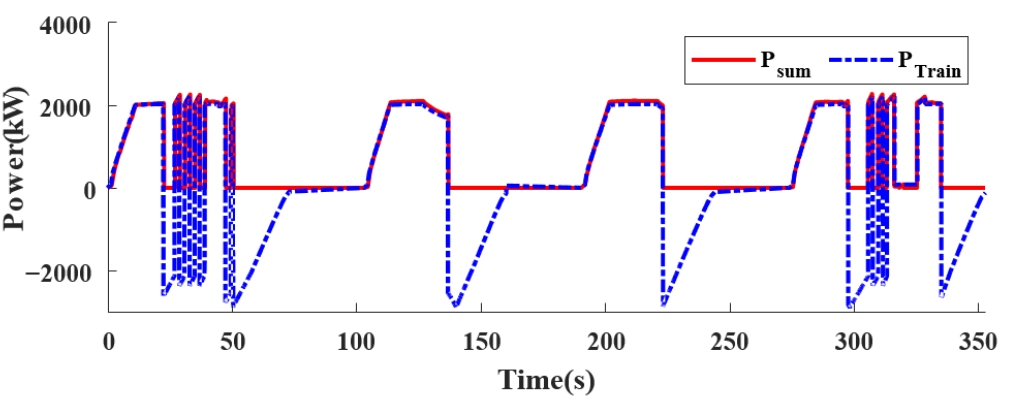
Figure 12. Comparison between sum of power of substation A, B and train load power in